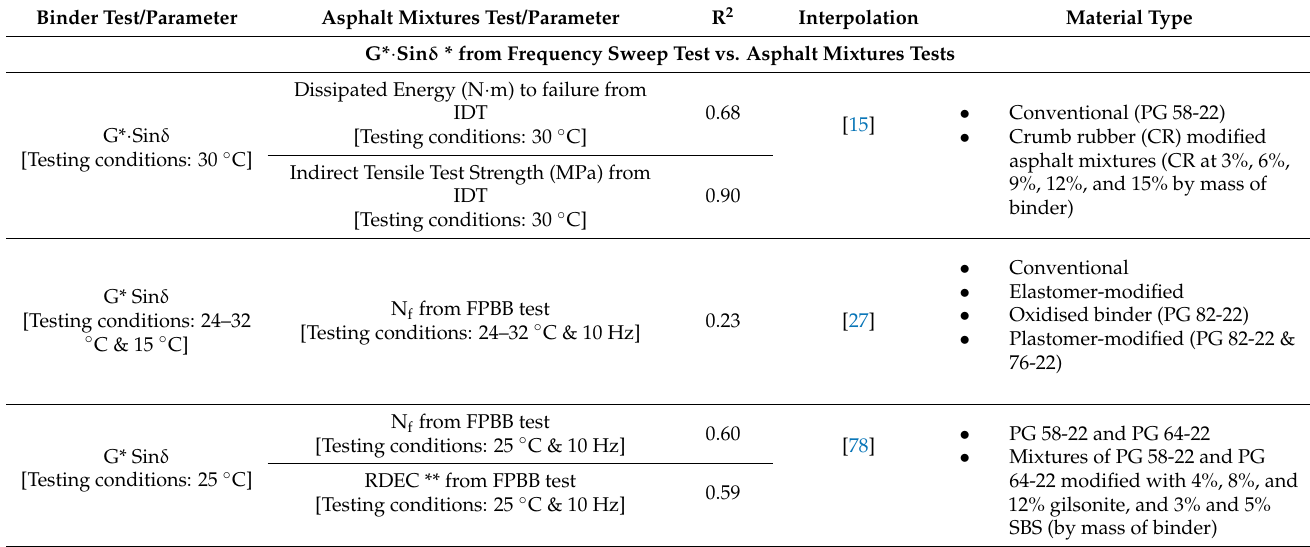
Table 4. Correlations between the properties of the bitumen from frequency sweep tests and cracking properties of asphalt mixtures from various